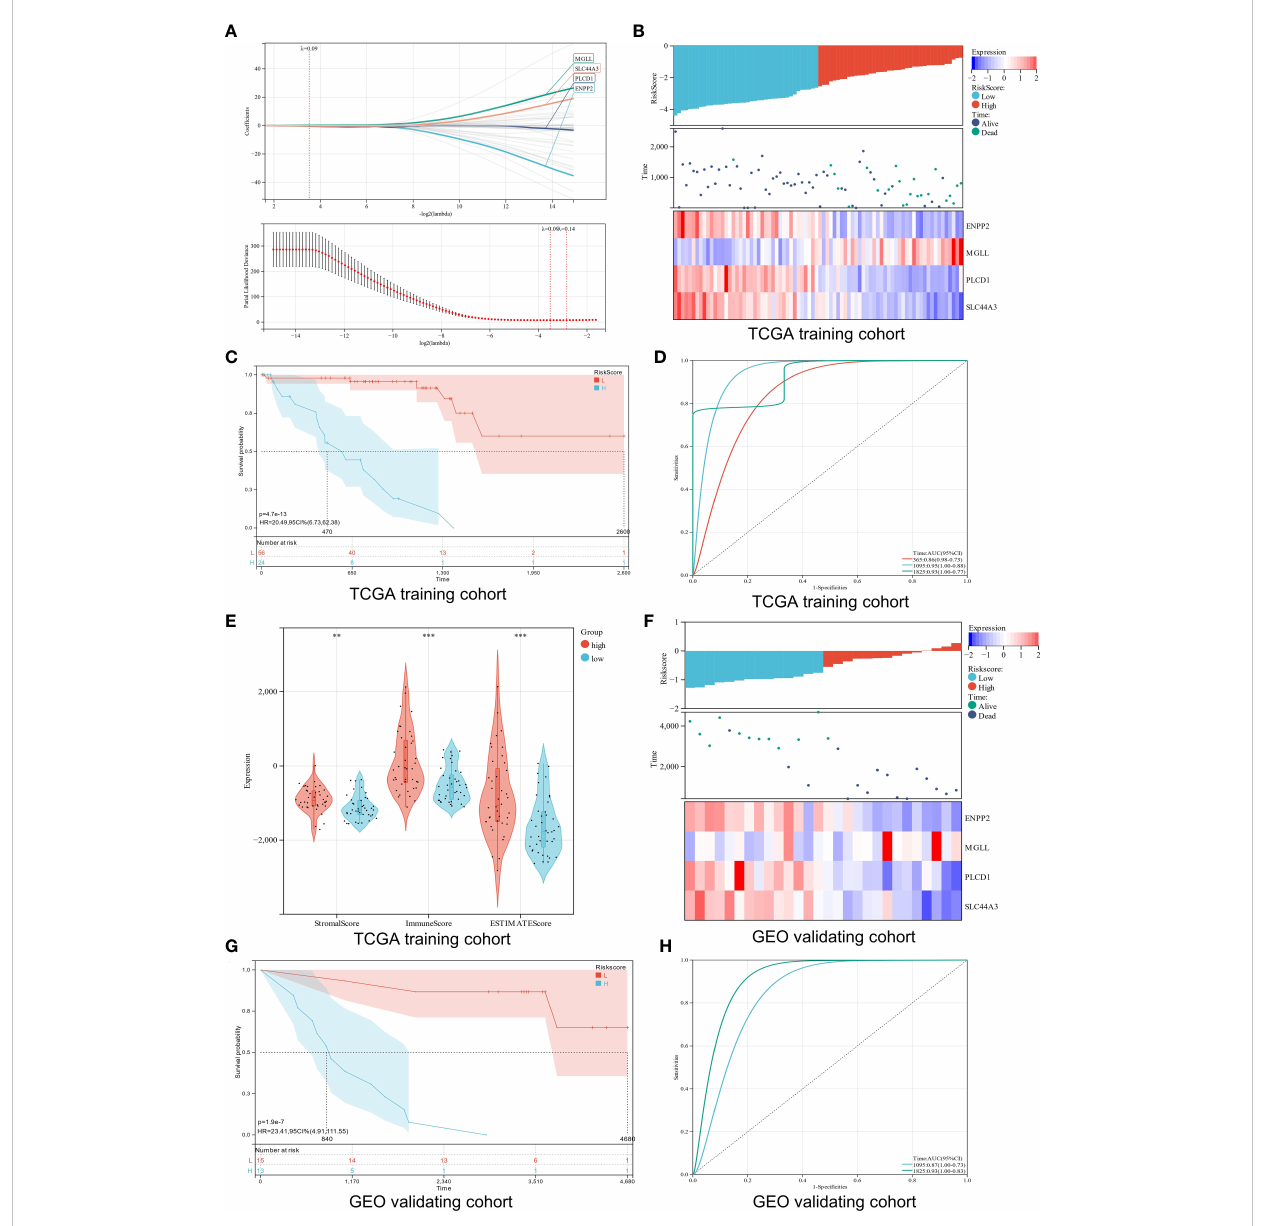
FIGURE 5 Construction and veri fi cation of a risk model. (A) Analysis using LASSO with a minimal lambda. (B) A heatmap displays the survival status and risk score of UM patients based on the expression of four potential genes in two groups. (C) Survival curves of UM patients in two different groups. (D) A risk model with ROC curves that are time-dependent. (E) Stomal score, immune score, and ESTIMATE score are calculated using the ESTIMATE algorithm. (F) Four candidate genes were expressed in the veri fi cation cohort with survival status and risk score indicated. (G) An analysis of the survival curves for high-risk and low-risk patients in the veri fi cation cohort. (H) The ROC curve for the risk model ’ s veri fi cation cohort. **p < 0.01; ***p <